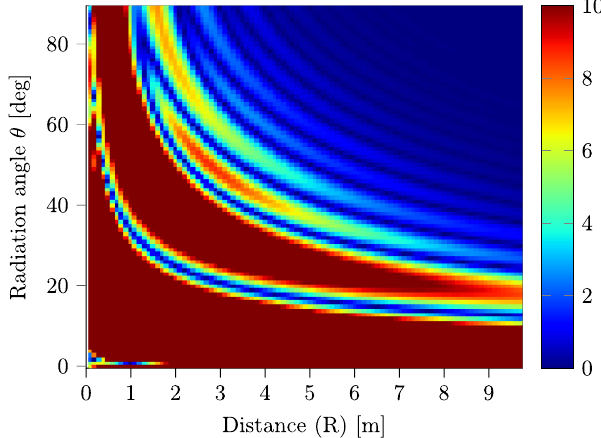
FIG. 6. Percentage error between 0.3 and 5.7 GHz for β ¼ 0 . 99 as a function of monitor angle and distance from the target. The target size is set to 1 . 4 βγλ for the reference wavelength of λ ¼ 1 m. Above 2 m radial distance, the radiation has a far field ref like distribution for the relevant frequency range for angles larger than